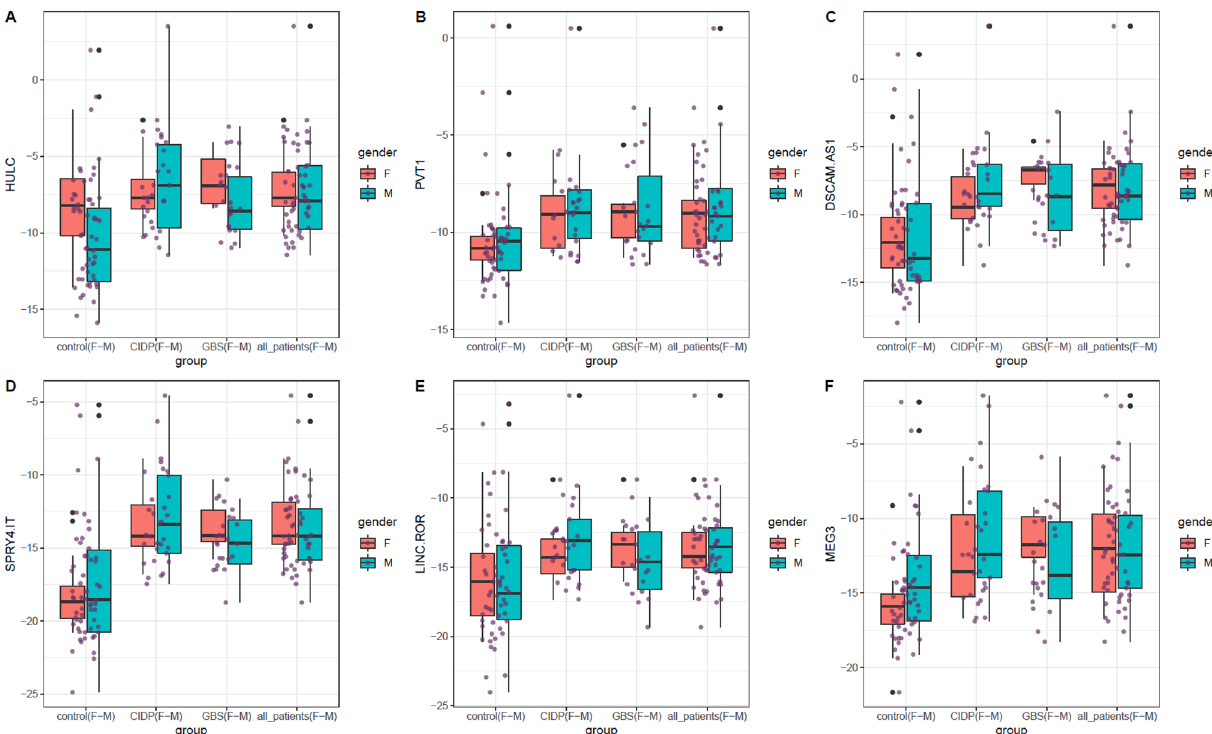
Figure 1. Expression levels of lncRNAs in study subgroups. Mean values and interquartile range are displayed. Purple dots show each expression level. Black dot represents outliers. (This figure has been depicted by R software) 20